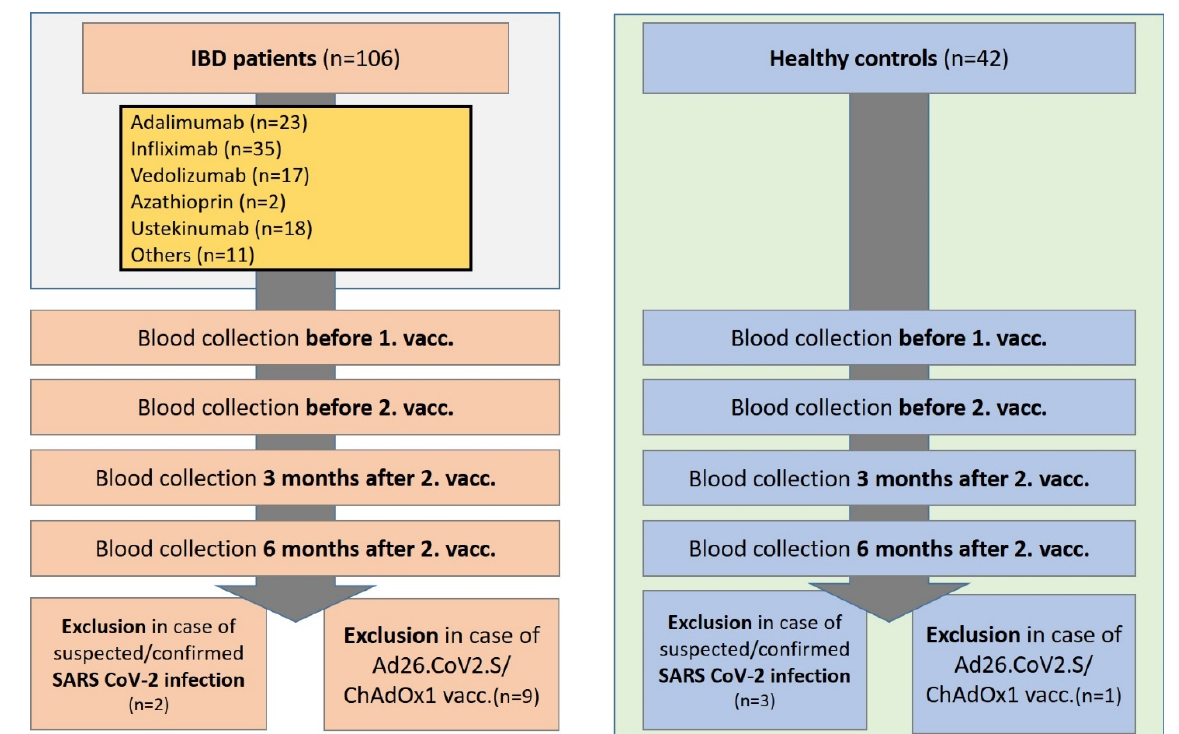
Figure 1. Study flow chart. Inclusion of IBD patients in the period from 01/2021 to 11/2021 on immunosuppressive medication and healthy controls. Blood collection within 48 h before the first and second vaccination, 3 and 6 months following the 2nd vaccination (+/− 7 days). Exclusion of patients and controls with suspected or confirmed SARS-CoV-2 infection, and ChAdOx1/Ad26.CoV2.S vac- cination. IBD, inflammatory bowel disease; SARS-CoV-2, severe acute respiratory syndrome coro- navirus type 2; vacc., vaccination.